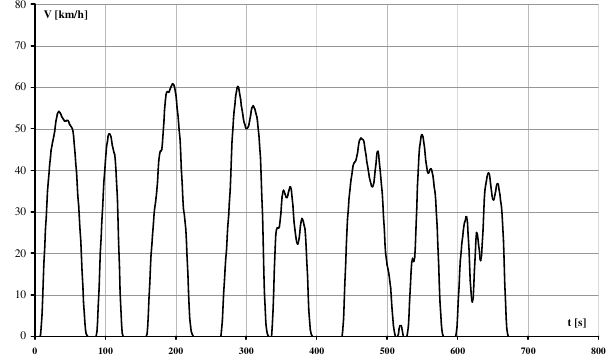
Fig. 2. The car speed variation at the average traffic